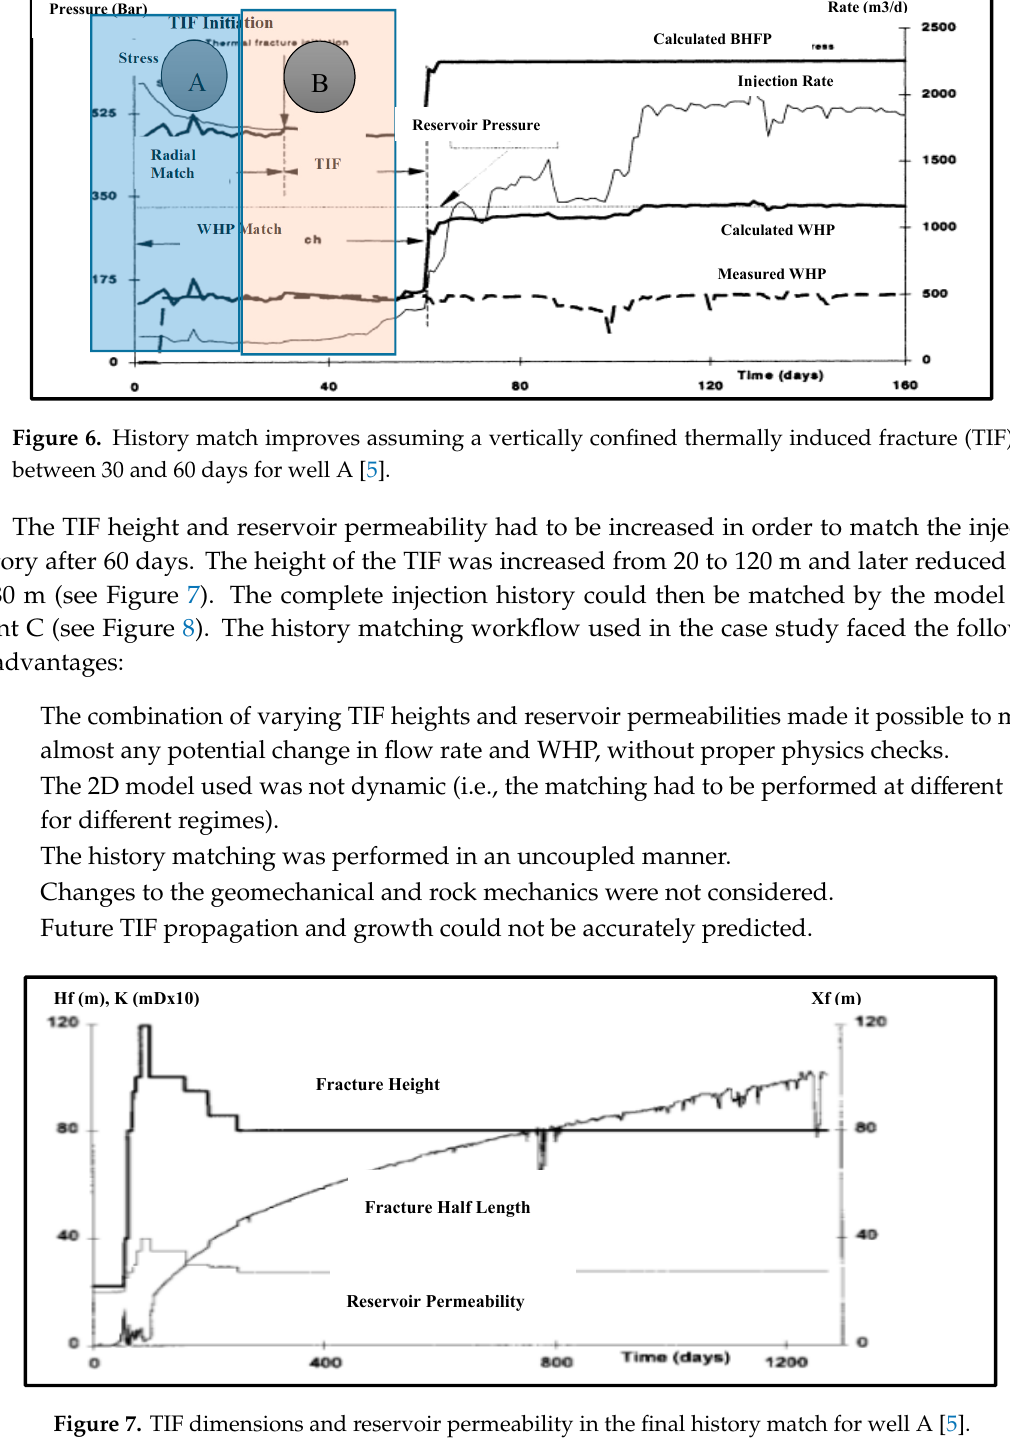
Figure 5. History match assuming radial flow for Well A [5].